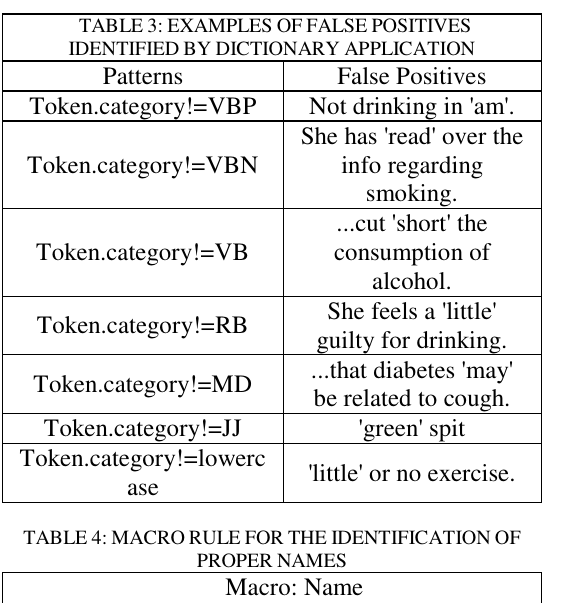
TABLE 3: EXAMPLES OF FALSE POSITIVES IDENTIFIED BY DICTIONARY APPLICATION Patterns